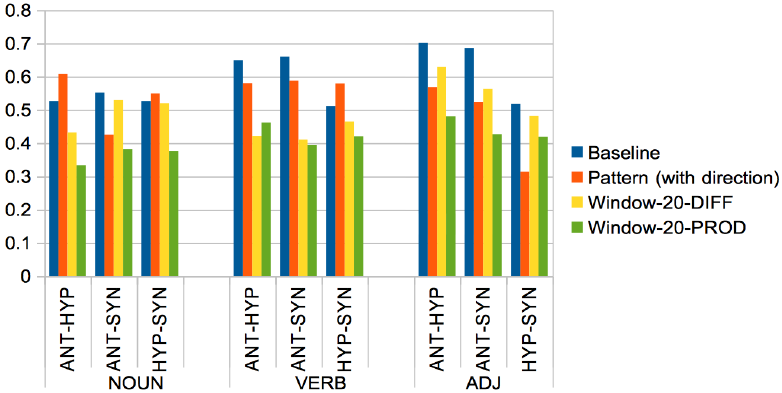
Classification re- sults ( accuracy ) using lmi-based window co-occurrence vs. lexico-syntactic pattern